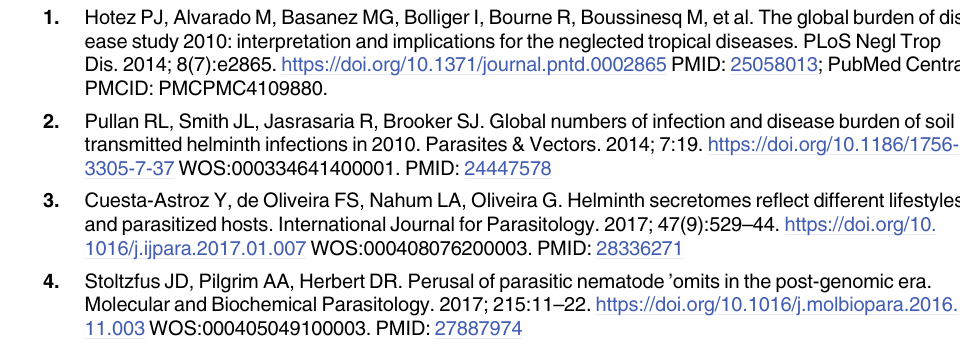
S7 Table. Core venom GO terms. List of enriched GO terms associated with the 52 core venom proteins between S . feltiae and S . carpocapsae